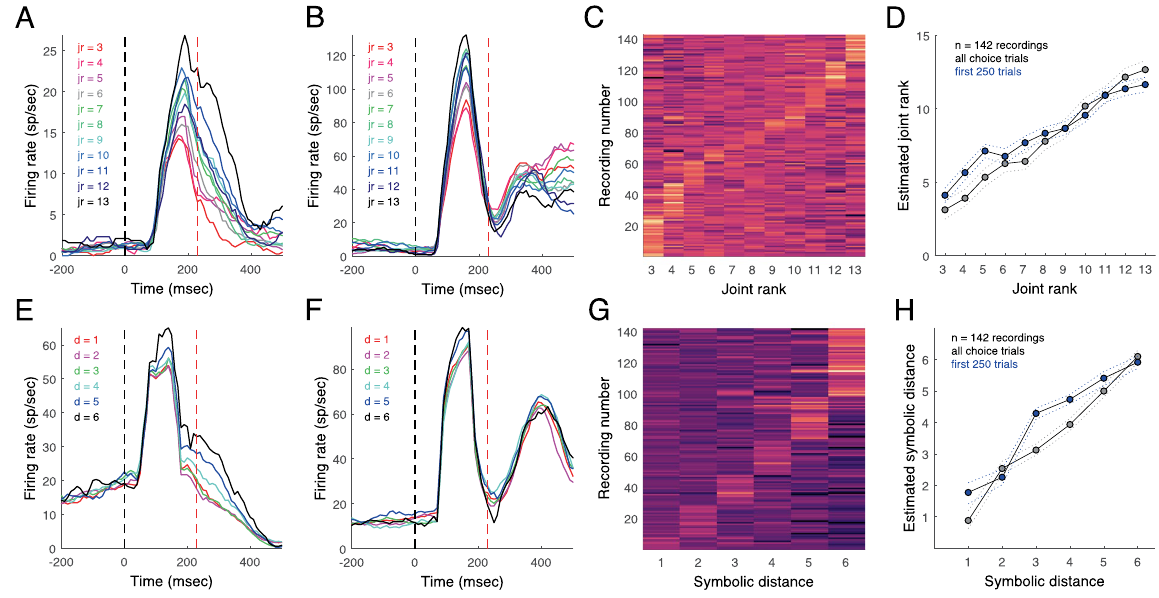
Figure 3. Joint rank and symbolic distance coding. ( A,B ) Example post-stimulus time histograms for two recordings with activity during choice trials sorted by joint rank. ( C ) Recordings ( n = 142) sorted by preferred joint rank based on z-scored firing rate. ( D ) Estimated joint rank using an optimal linear estimator. Dotted lines are 95% confidence intervals for all trials based on 10,000 bootstrap iterations. ( E,F ) Example post-stimulus time histograms for two recordings sorted by symbolic distance (different recording sessions than A,B ) ( G) Recordings sorted by preferred symbolic distance. ( H ) OLE estimated symbolic distance with bootstrap estimates of 95% confidence interval.